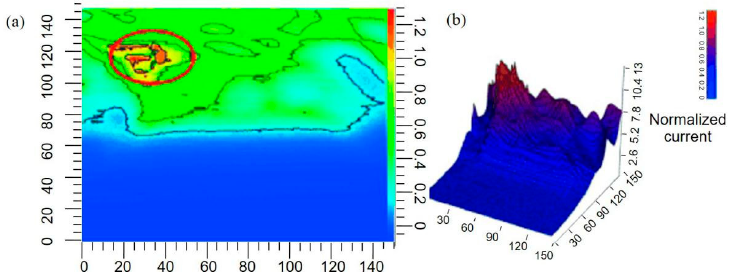
Figure 15 . Real-time areascan series of a bottom gold electrode after 37 hours of bacteria electrogenic experiments. ( a ) The contour map, whereas ( b ) is the corresponding 3D image. Copyright (2015) John Wiley and Sons, Ltd.